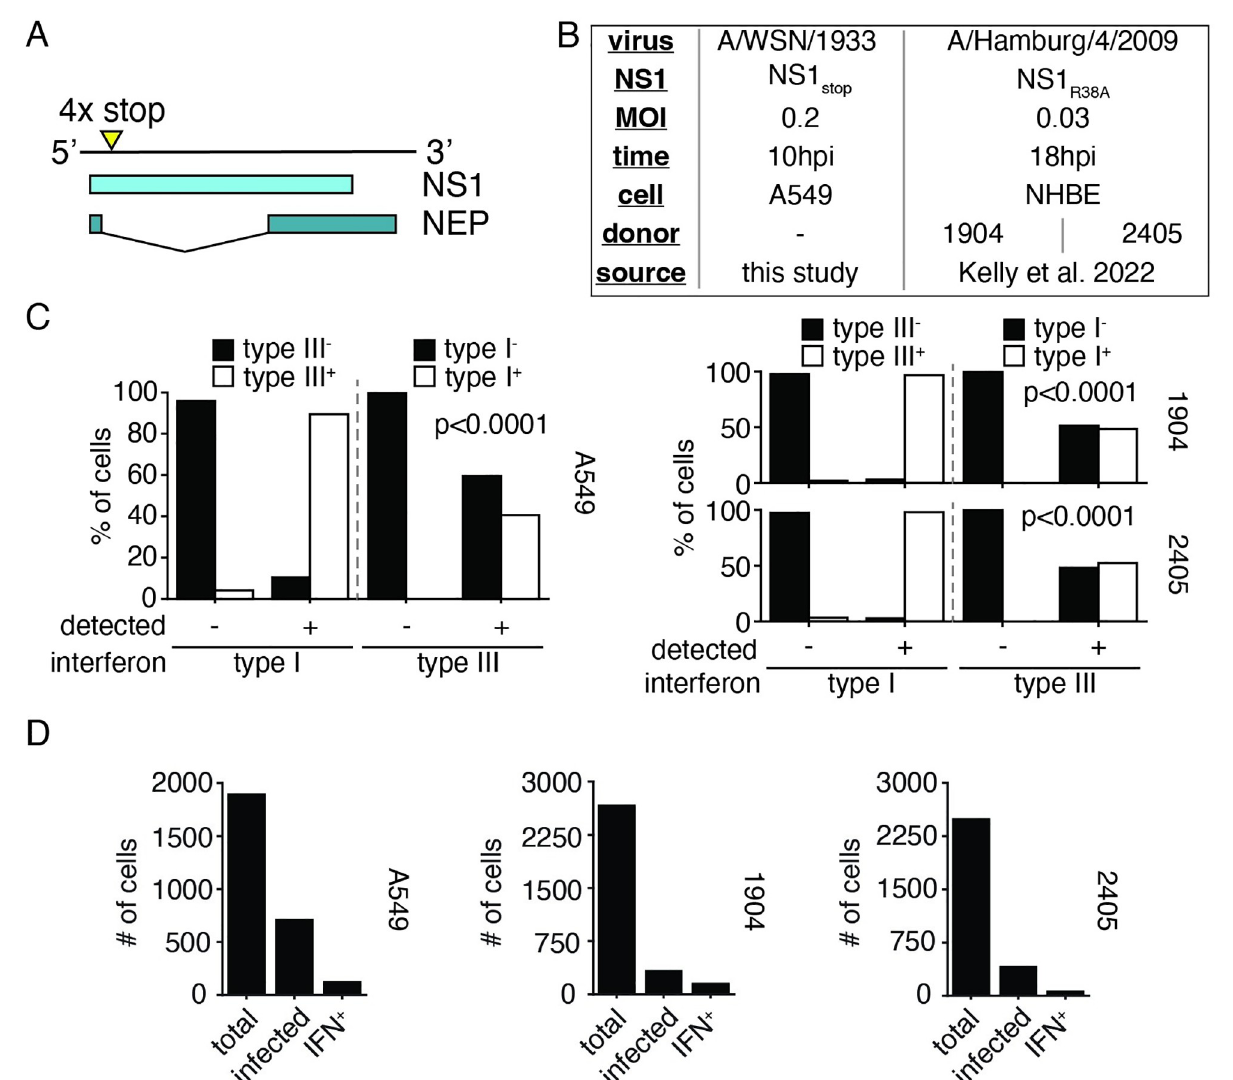
Fig 1. Summary of single-cell datasets used in this study. (A) Diagram of the NS segment in the (+) orientation showing NS1 and NEP open-reading frames. Stop codons were introduced at the indicated site to generate NS1 stop . Full genome sequence in S1 File. (B) Summary of datasets presented in this paper, either generated for the express purpose of this effort, or reanalysis of a prior study from Kelly et al . [26] Analysis pipeline schematicized in S2 Fig. Genome sequence to align Kelly et al . data in S2 File (C) Fraction of cells annotated as positive for either type I or type III interferon expression were further assessed for expression of type III or type I interferon expression. Each individual single-cell experiment was analyzed seperately, labeled by cell type or donor. Type I and type III expression were associated at levels unlikely to be driven by chance (Fisher’s exact test, p values shown) across all experiments. (D) Numbers of cells meeting indicated thresholds in our NS1 stop single-cell RNAseq data. Analysis used to set thresholds shown in S3, S5 and S7 Figs. Wild-type infections, for comparison, shown in S4, S6 and S8 Figs, respectively.